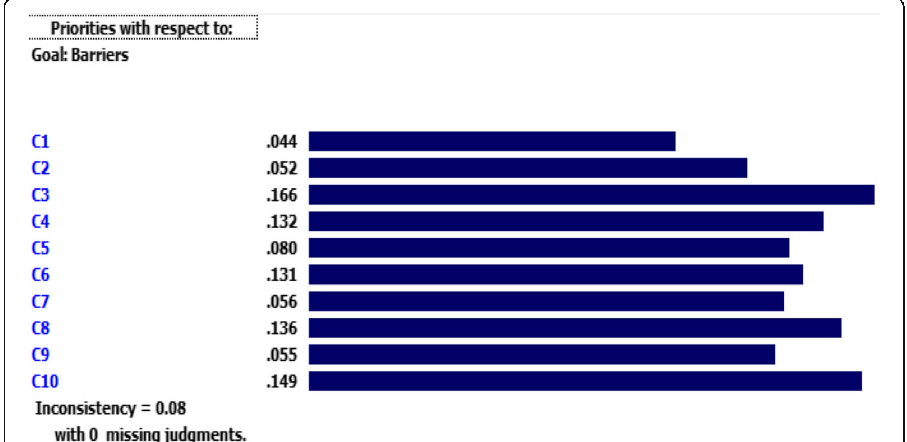
Fig. 1 The output of Expert Choice